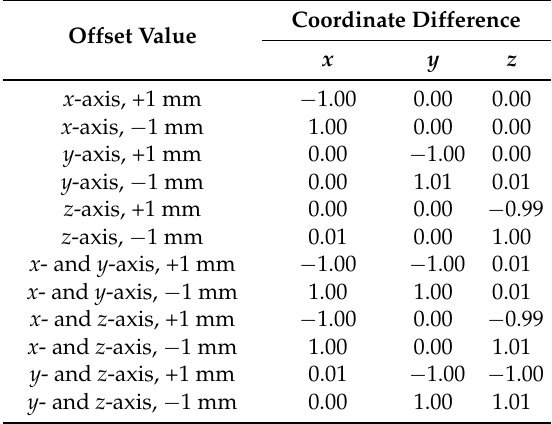
Table 2. Experiment results of the coordinate offset simulation. (Unit: mm). Coordinate Offset Value